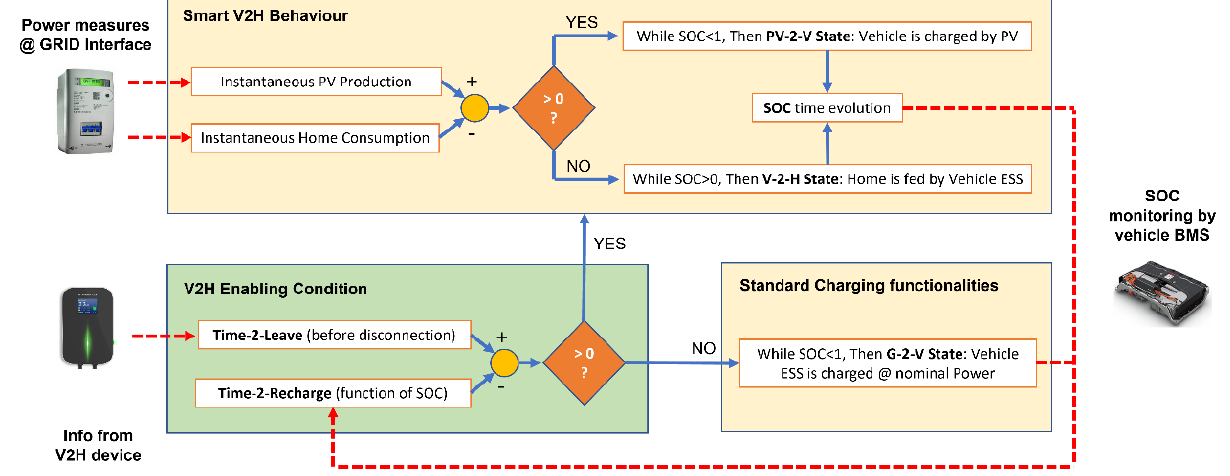
Figure 7. Sketch of the proposed algorithm for the optimal energy management of the V2H system.